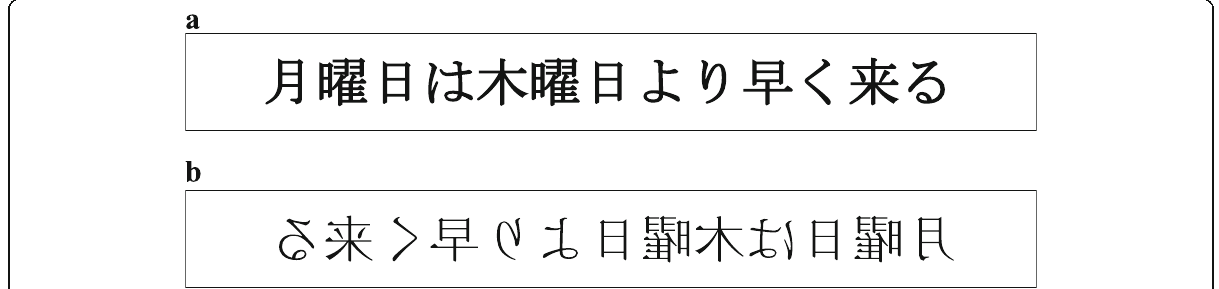
Fig. 1 a An example of a horizontal standard-orthography prime. b An example of a horizontal mirror-orthography prime. The English